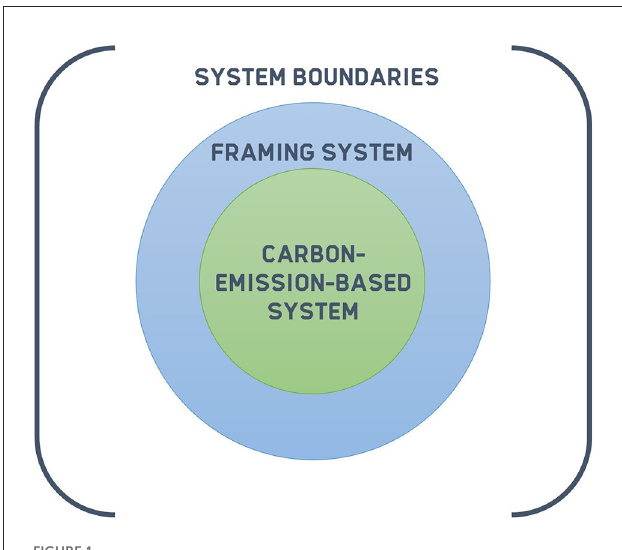
FIGURE1 Schematic overview of the Net-Zero-2050